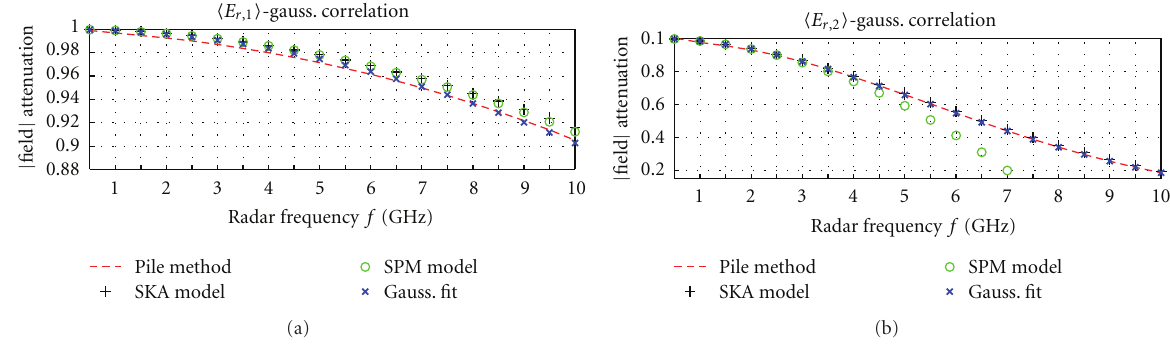
Figure 2: Frequency behavior of the amplitude attenuation of the coherent scattered fields (cid:2) E r ,1 (cid:3) and (cid:2) E r ,2 (cid:3) (V polarization) in the frequency band f ∈ [0 . 5;10 . 0]GHz, comparatively to the flat case: results from the PILE code and comparison with the SKA and SPM2 asymptotic models for Gaussian surfaces. The upper and lower correlation lengths are L c A = 10 . 0mm and L c B = 30 . 0mm, respectively.